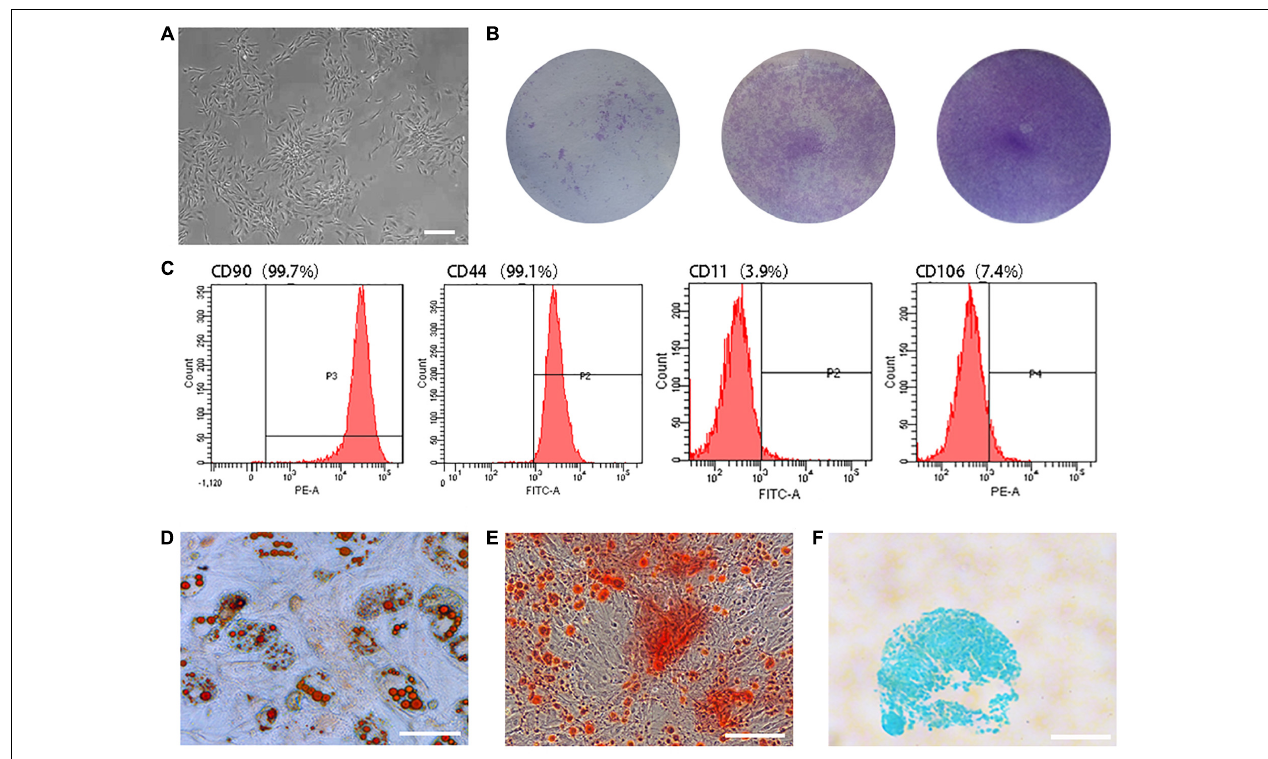
FIGURE 1 | Characterization of TSCs. (A) Primary TSCs were spindle-shaped and reached 40–50% confluence on Day 10 after seeding. (B) After 7 days of culture, cell colonies were visualized by crystal violet staining. The initial seeding densities were 1 × 10 3 , 1 × 10 4 , and 1 × 10 5 per well, respectively. (C) Flow cytometry analysis revealed that 99.7% of cells expressed CD90 and 99.1% expressed CD44. Meanwhile, only 3.9% and 7.4% expressed CD11 and CD106. (D) Lipid droplets were observed by oil red O staining after adipogenic differentiation induction of TSCs. (E) Mineralized nodules were observed by alizarin red staining after osteogenic differentiation induction of TSCs. (F) Acid mucopolysaccharide was observed by Alcian blue staining after chondrogenic differentiation induction of TSCs. All bars: 200 µ